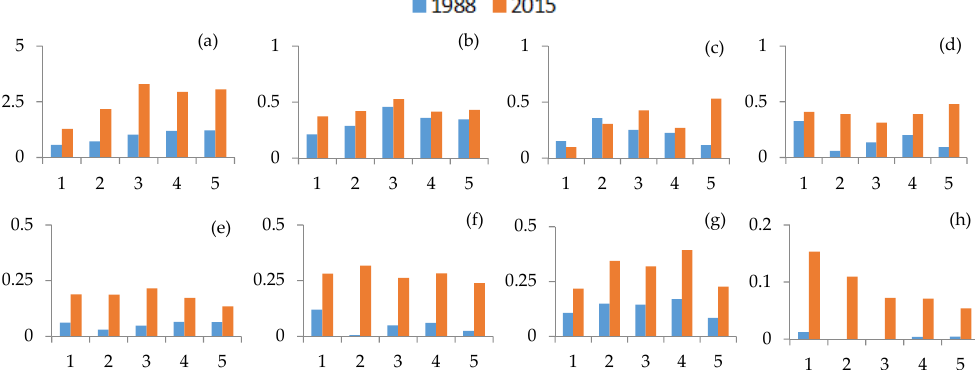
Figure 9. PDs of the bays in 1988 and 2015. ( a ) Hai Loc Bay; ( b ) Dam Ha Trung Bay; ( c ) Danang Bay;